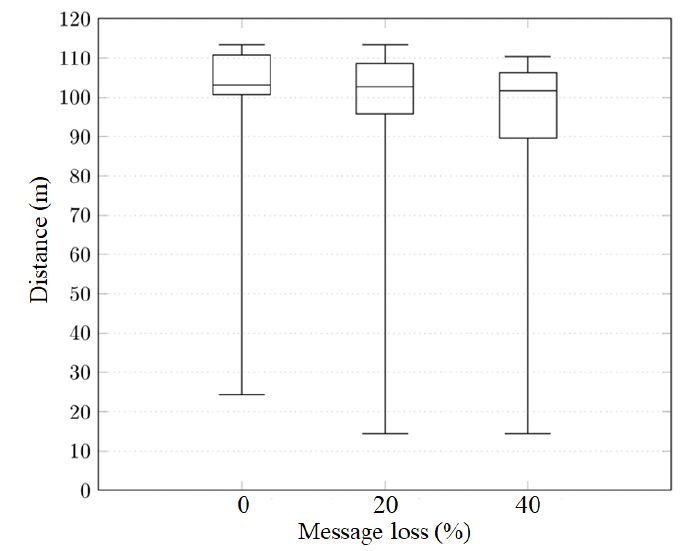
Figure 15. Message loss